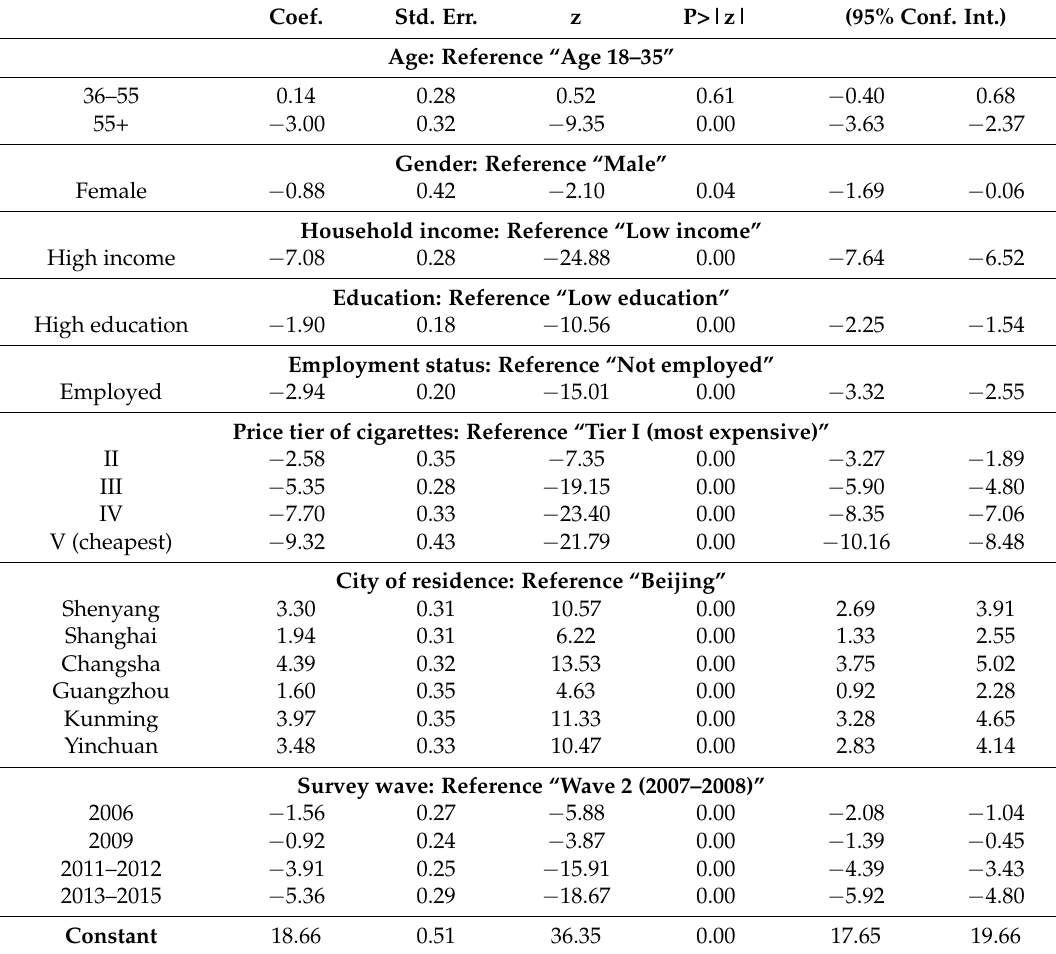
Table 4. Generalized Estimating Equations (GEE) estimation of Relative Income Price (RIP) in China, 2006–2015. Coef. Std. Err. z P>|z| (95% Conf.